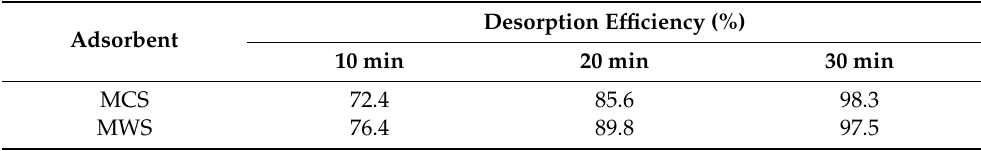
Table 7. Desorption of ions from adsorbents using 0.1 M